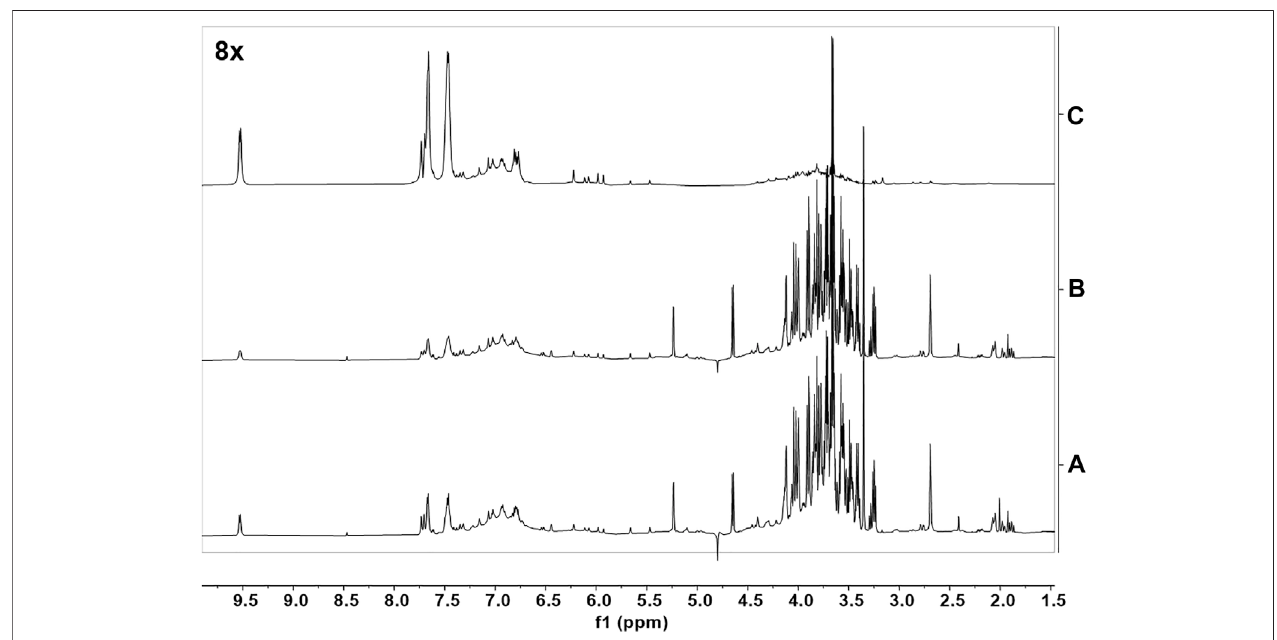
FIGURE7| NMR bindingstudies withA β 1-42 oligomers. (A) The 1 H-NMR spectrumofasolutioncontainingCCHE extract (15 mg/ml); (B) 1 H-NMR spectrum ofa solution containing CCHE extract (15 mg/ml) and A β 1-42 protein (120 μ M); (C) STD NMR spectrum of the same sample of (B) . Samples were dissolved in deuterated phosphate buffer, pH 7.4. STD spectra were acquired with 1,024 scans and 2 s saturation time at 600 MHz, 25 ° C.